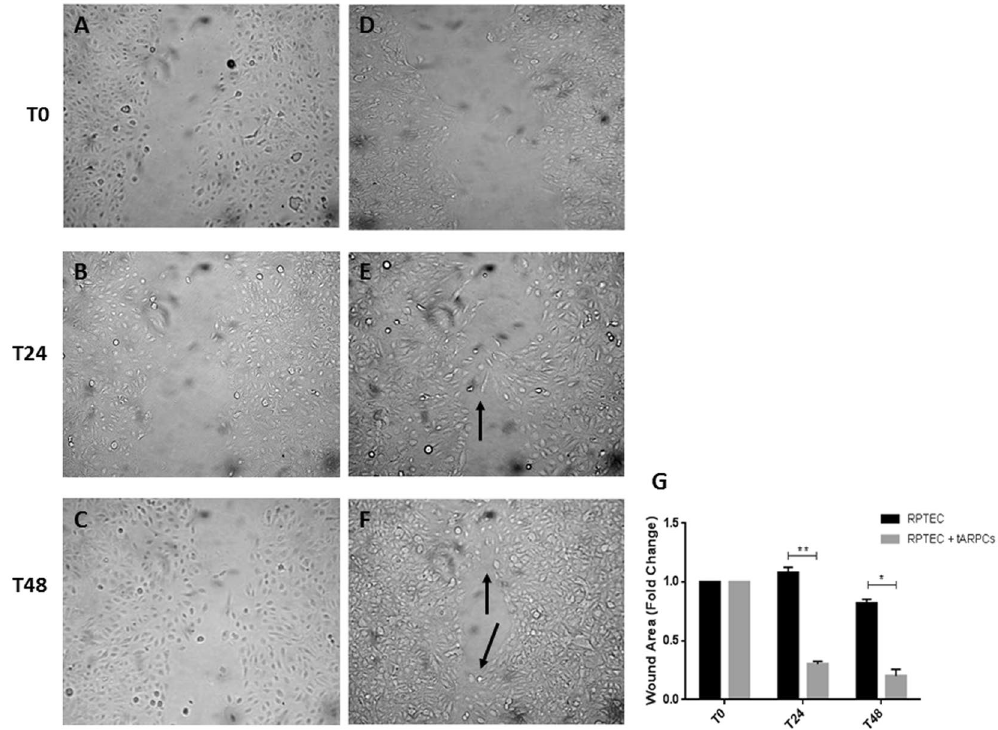
Figure 1. tARPCs can repair RPTECs physically injured. The wound healing assay showed that tARPCs can repair physically damaged RPTECs. A scratch was performed on tubular cell monolayers to simulate a physical damage. Subsequently, tubular cells were incubated alone ( A – C ) or in co-culture with ARPCs on transwells ( D – F ). Images were captured at phase contrast microscopy at intervals of 0, 24 and 48 hours (T0, T24 and T48, respectively) to detect the gradual repair of the gap. When RPTECs were in co-culture with tARPCs, they displayed an increased capacity to fill in the damaged area ( E , F) , when compared to RPTECs cultured alone ( B – C ). After 24 hours, the scratch in co-cultured RPTECs already started to close and contact points were seen (E, black arrow). At 48 hours, many more junction points were observed between gaps in RPTECs co-cultured with ARPCs ( F , black arrows) compared RPTEC cultured alone. ( G ) Quantization results are expressed as a ratio between area of scratches at T48 and at T24 compared to the scratch area at T0. Plots represent 3 independent experiments using ARPCs from 3 different subjects; * P < 0.05, ** P <